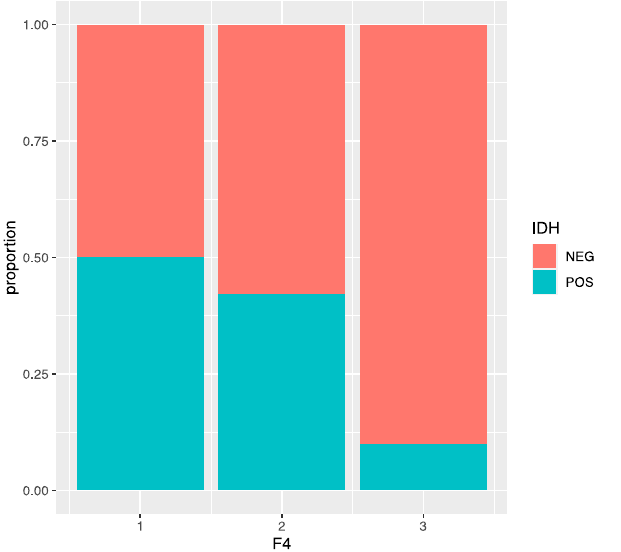
Figure 4. Bar plot representing the distribution of IDH status according to the F4 VASARI variable.